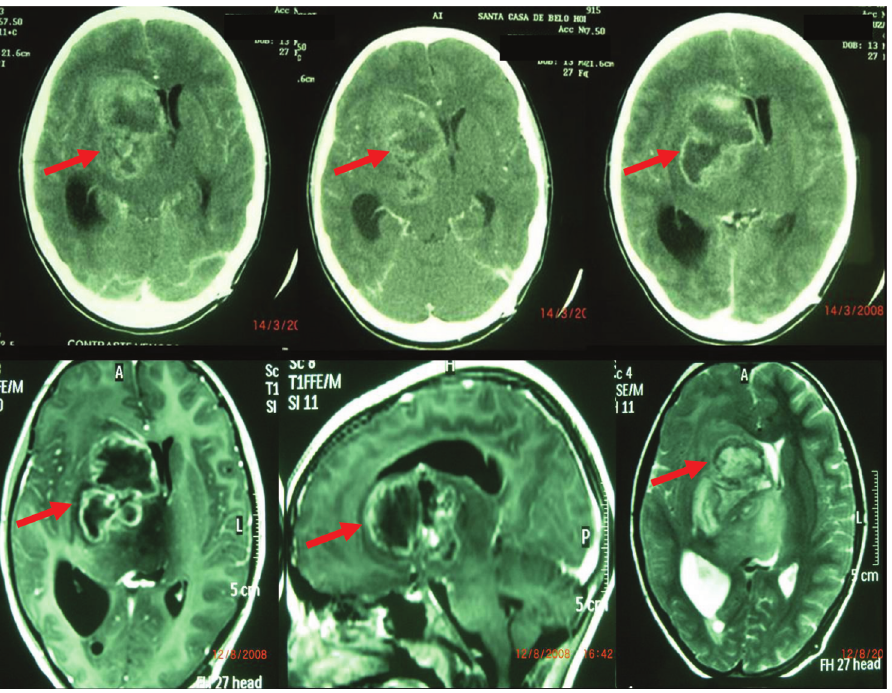
Figure 3 - CT (above) and MTI (below): A large lesion impinging on the thalamus and basal ganglia with peripheral contrast uptake and